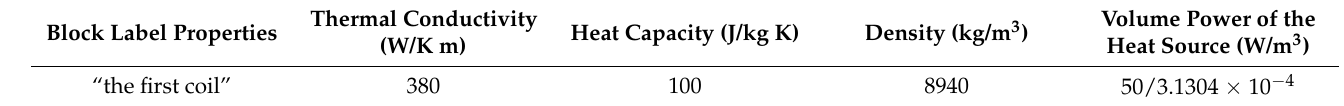
Table 3. Properties of the “the first coil”